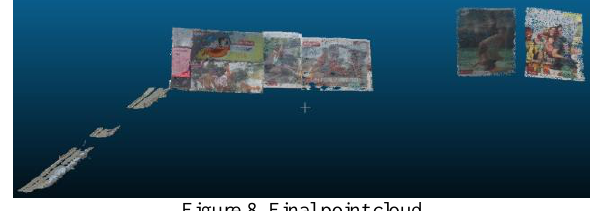
Figure 8. Final point cloud